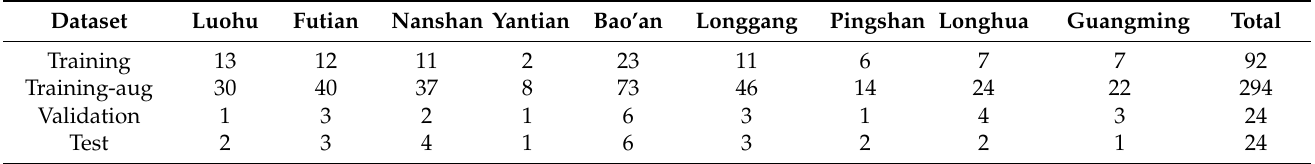
Table 2. The distribution of samples in the Shenzhen